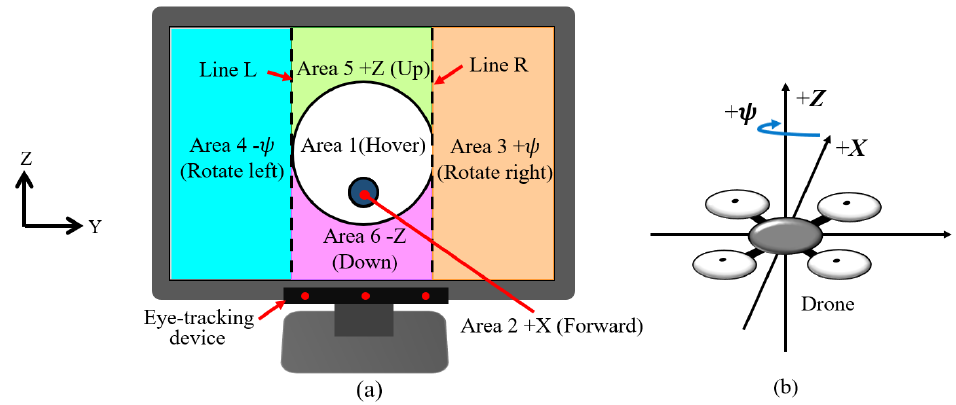
Figure 2. Control screen and the coordinates around the drone. ( a ) Control screen; ( b ) Coordinate system.